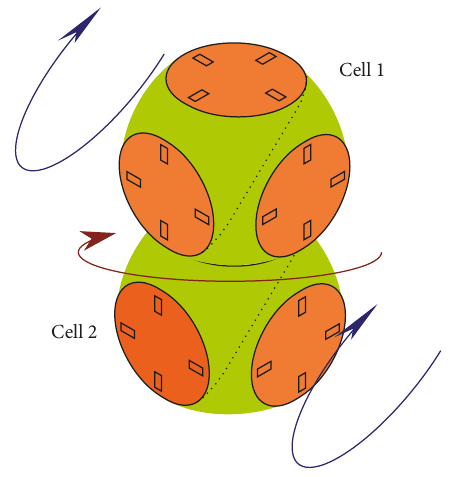
Figure 15: Model diagram of roombot